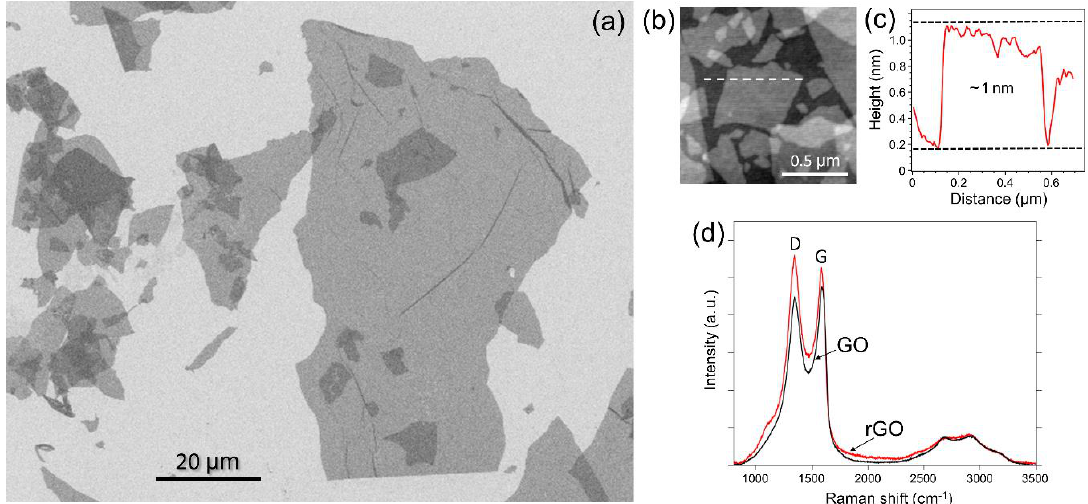
Figure 1. Characterization of graphene oxide (GO) and reduced graphene oxide (rGO). ( a ) Scanning electron microscopy (SEM) image of rGO flakes on a Si / SiO 2 substrate. ( b ) Atomic force microscopy (AFM) image of rGO flakes on a Si / SiO 2 substrate. ( c ) AFM height profile across the rGO flake, which was measured along the dashed line in panel (b). The flake has a height of about 1 nm. ( d ) Raman spectra of GO and rGO.